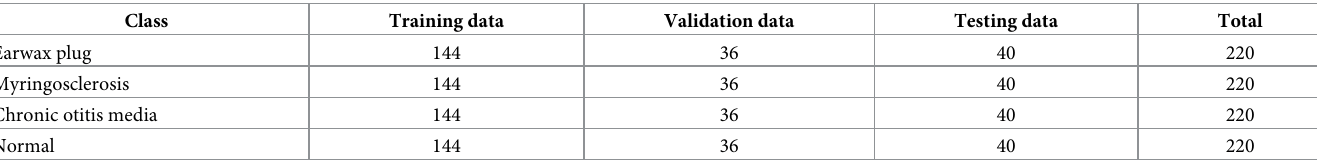
Table 1. Data distribution for classification test.